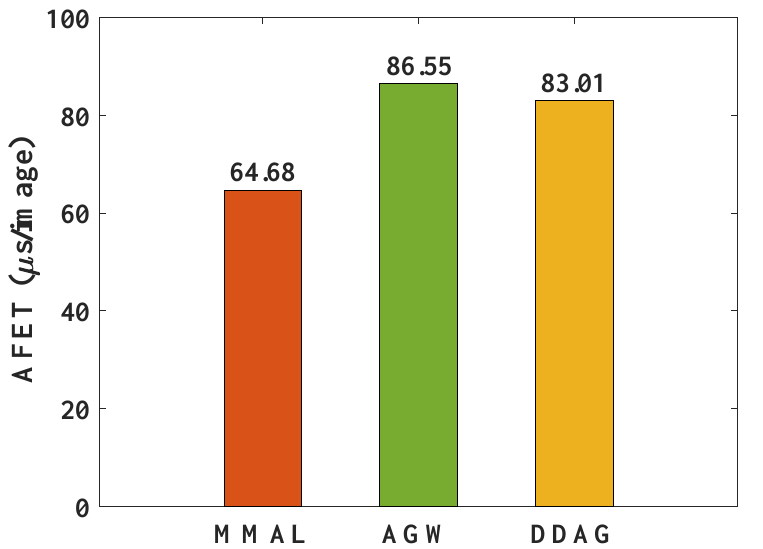
Figure 8. The running time performance of our MMAL approach and state-of-the-art methods. The batch size is set to 100 during